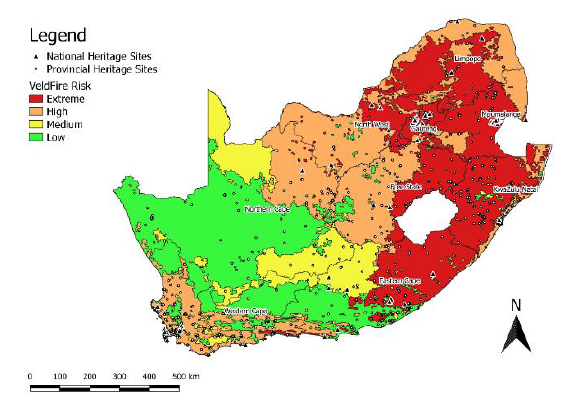
Figure 3: Map showing National and Provincial Heritage Sites in relation to identified VeldFire risk (SAHRA, 2019)